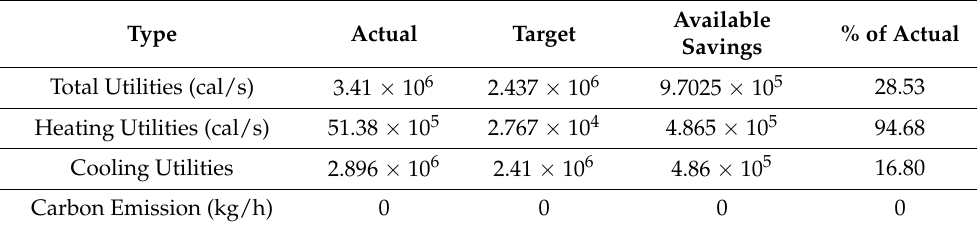
Table 6. Total utilities, heating utilities, cooling utilities, and carbon emission.